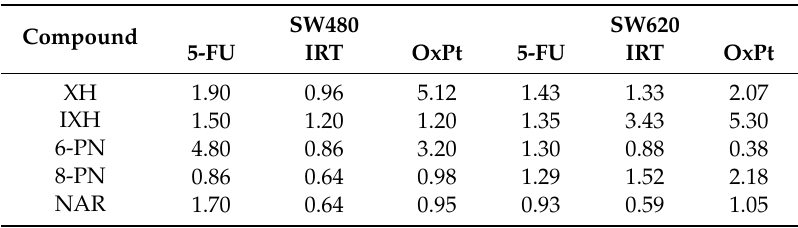
Table 2. Combination indexes (CI) of cytostatics (OxPt, 5-FU, IRT) and NAR, XH, IXH, 6-PN, and 8-PN in SW480 and SW620 after 72 h exposition. CIs were calculated as a function of the fraction a ff ected (Fa), which represents the percentage of growth inhibition (0.8 = 80%) and was evaluated using the NRU assay. SW480 SW620 Compound 5-FU IRT OxPt 5-FU IRT OxPt XH 1.90 0.96 5.12 1.43 1.33 2.07 IXH 1.50 1.20 1.20 1.35 3.43 5.30 6-PN 4.80 0.86 3.20 1.30 0.88 0.38 8-PN 0.86 0.64 0.98 1.29 1.52 2.18 NAR 1.70 0.64 0.95 0.93 0.59